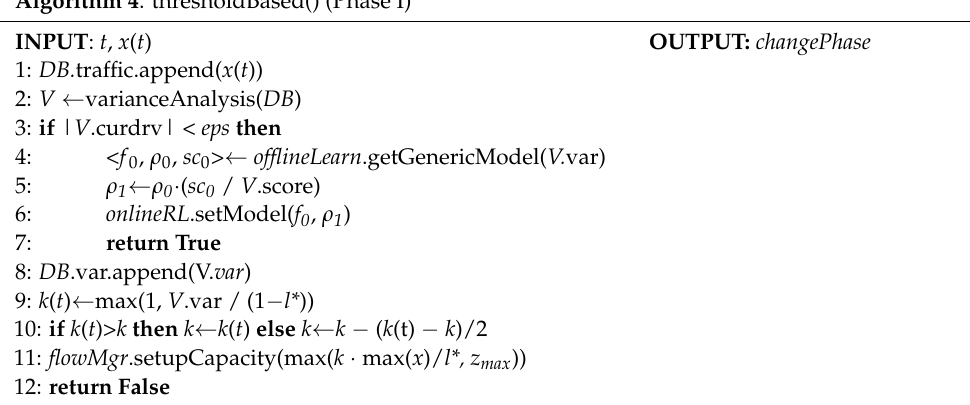
Algorithm 4 . thresholdBased() (Phase